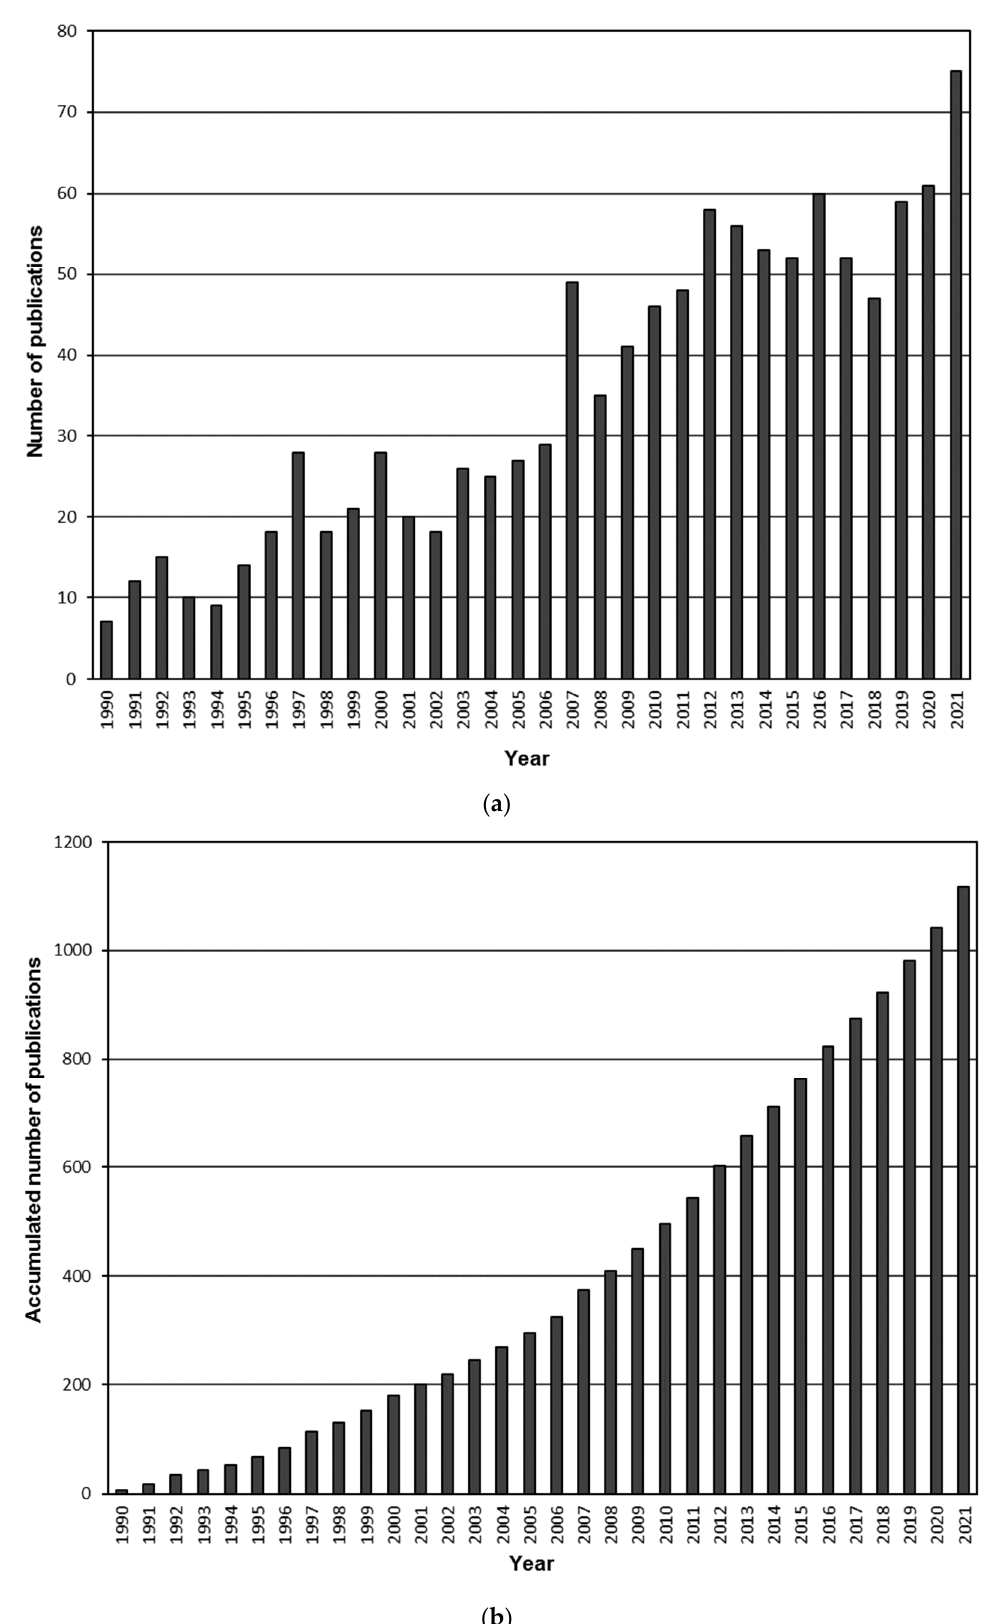
Figure 2. Annual ( a ) and accumulated ( b ) publication output.